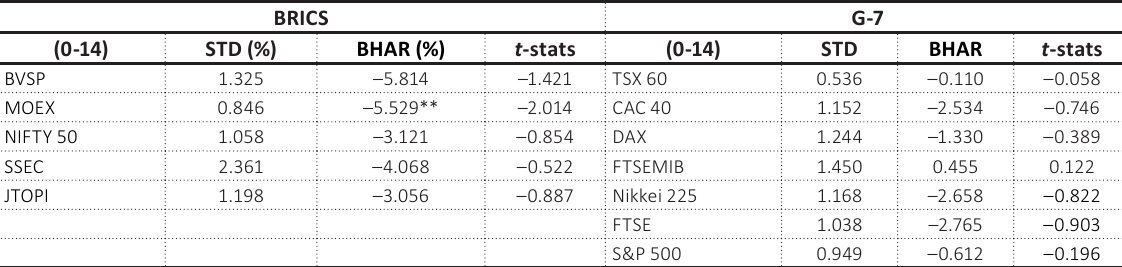
Table 3. BHAR in the event window (0-14) for G-7 and